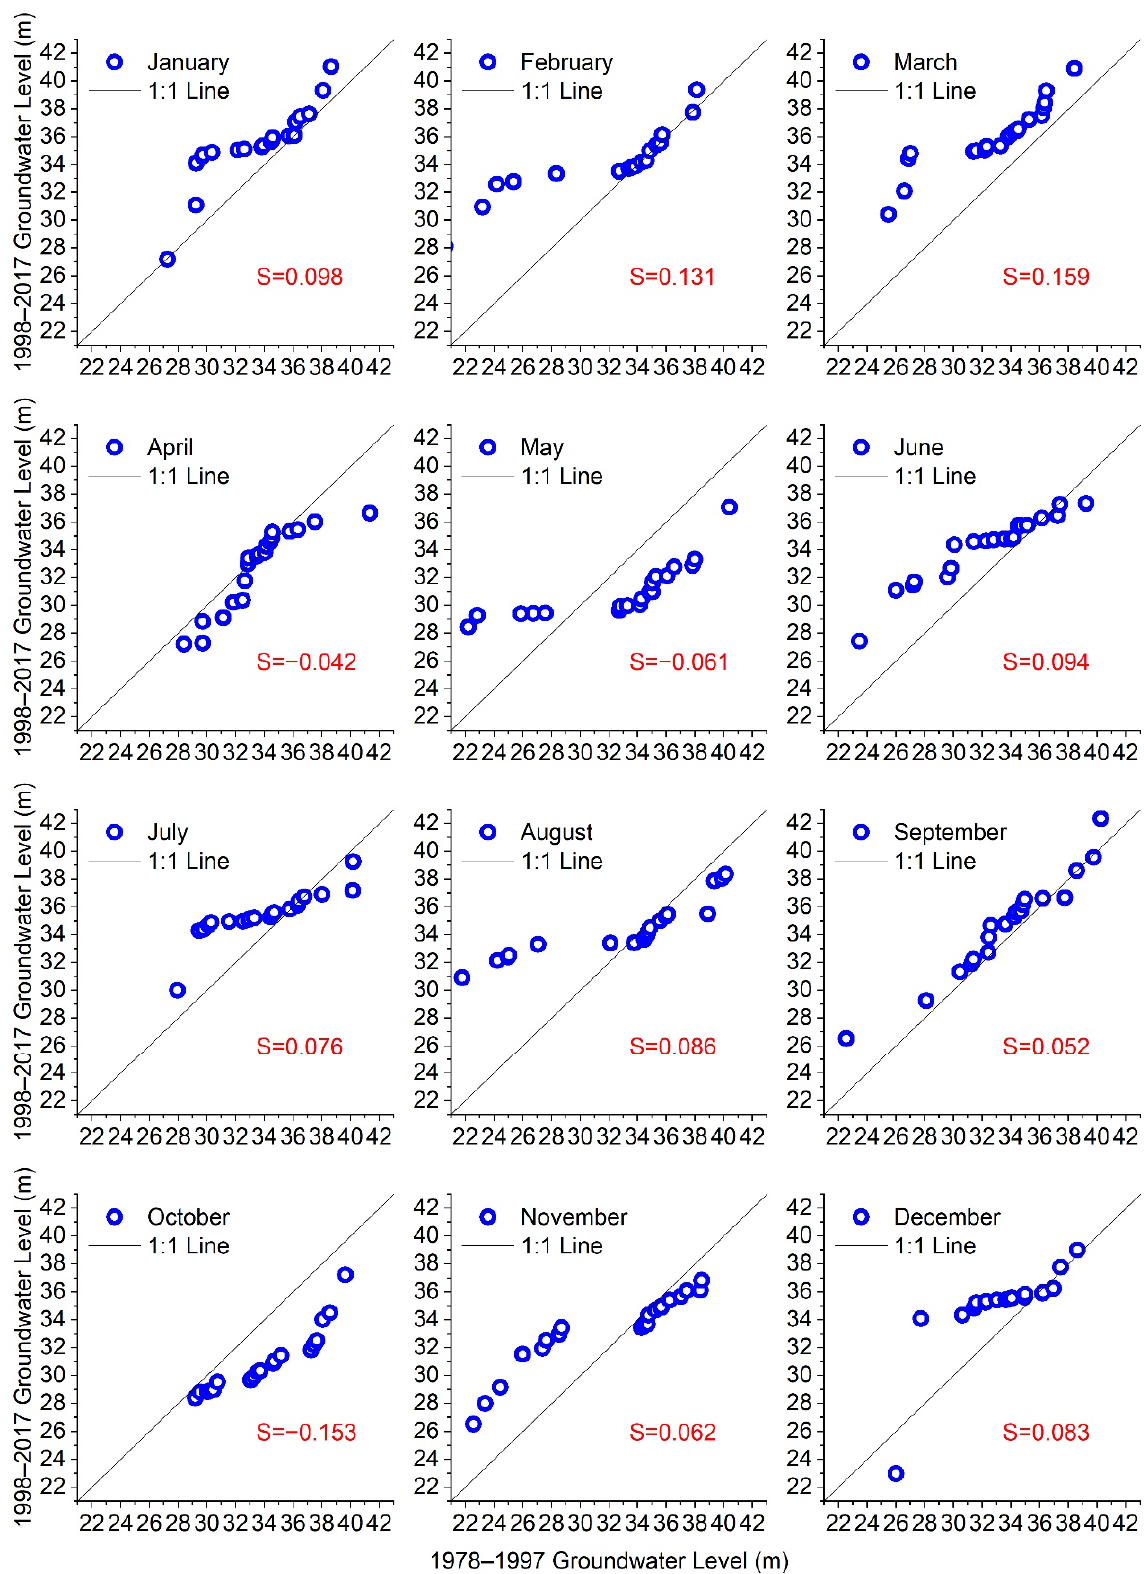
Figure 5. Results of the innovative trend analysis of the monthly groundwater level.